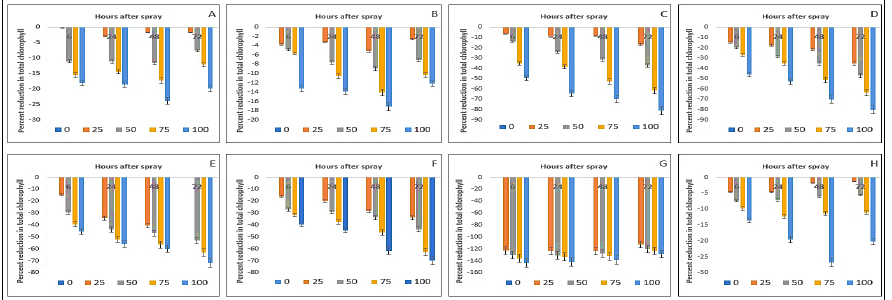
Figure 5. Reduction (%) of total chlorophyll as a consequence of parthenium leaf methanolic extracts on several crops and weeds: ( A ) -Bambara groundnut; ( B ) -Maize; ( C ) - D. sanguinalis ; ( D ) - E. indica ; ( E ) - A. conyzoides ; ( F ) - C. iria ; ( G ) - E. hirta , and ( H ) - C. difformis . Figure 6 and Tables S1 – S5 display the total chlorophyll response surface plot as a consequence of parthenium leaf methanol extract on Bambara groundnut, maize, D. san- guinalis, E. indica, A. conyzoides, C. iria, E. hirta, and C. difformis . The chart shows that as the concentration increased, the total chlorophyll content gradually declined. However, 72